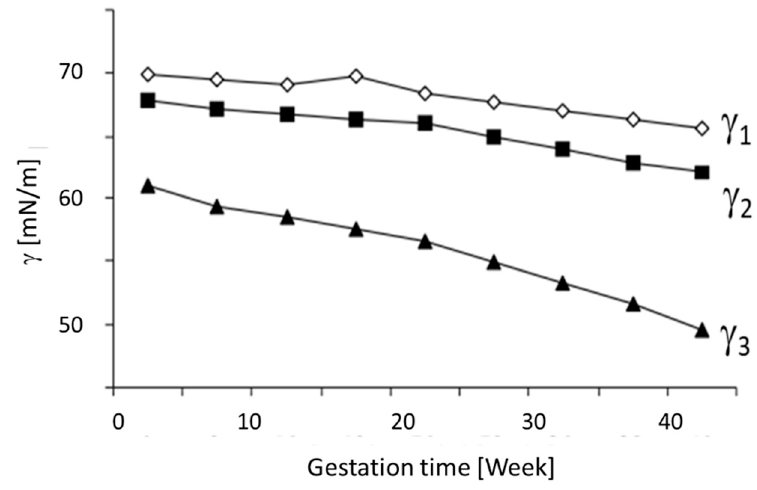
Figure 2. Changes in selected surface tension parameters for blood serum during pregnancy. Data taken with permission from [2].